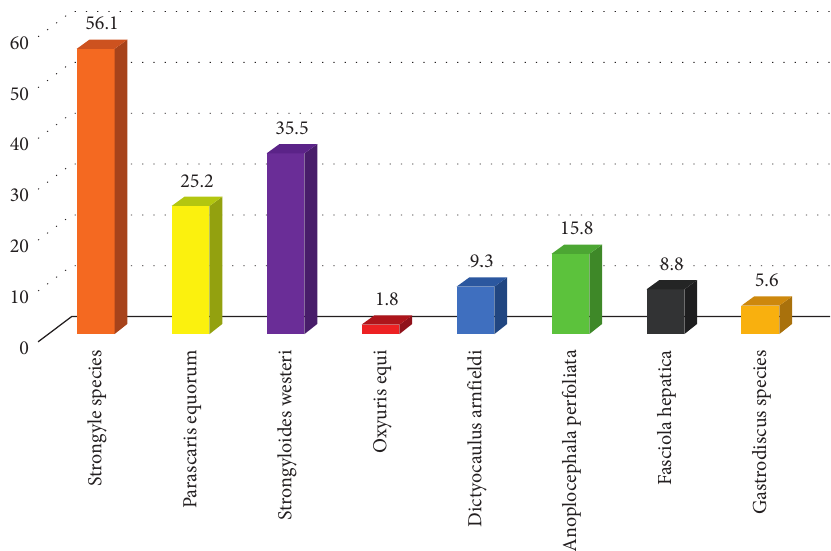
Figure 2: Proportion of different species of GI helminths identified in the study area. Table 2: Distribution of species of GI helminths identified from donkeys and horses. Parasites species Strongyle species.